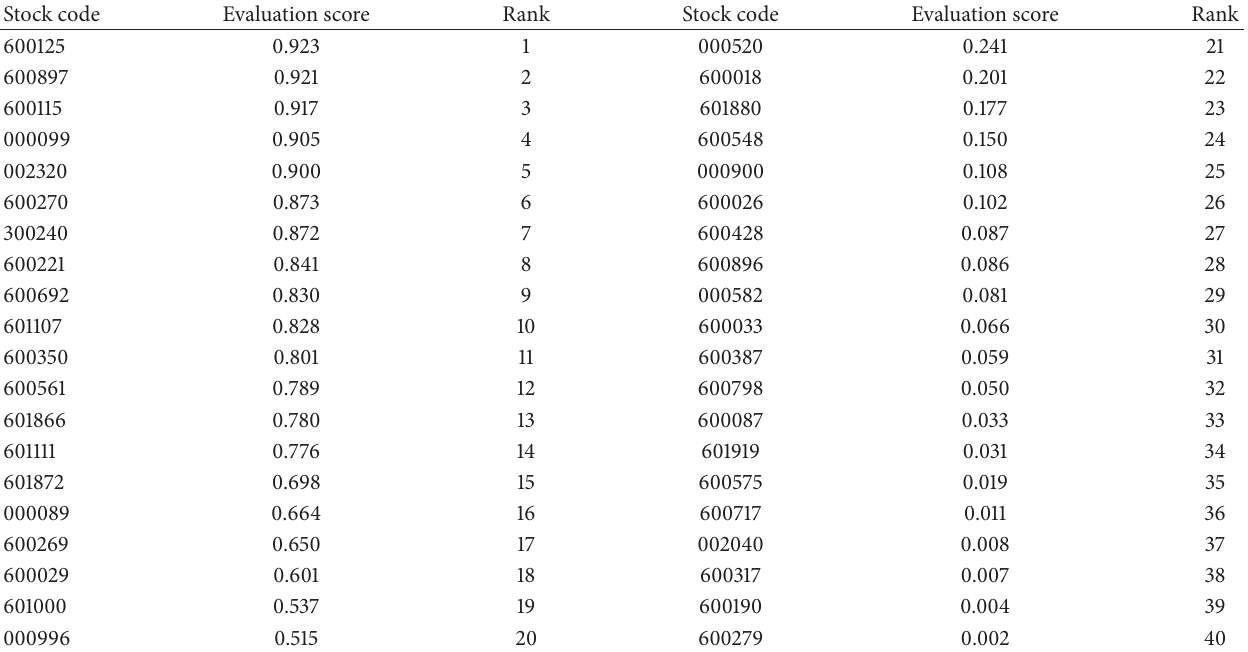
Table 5: Score and ranking of 40